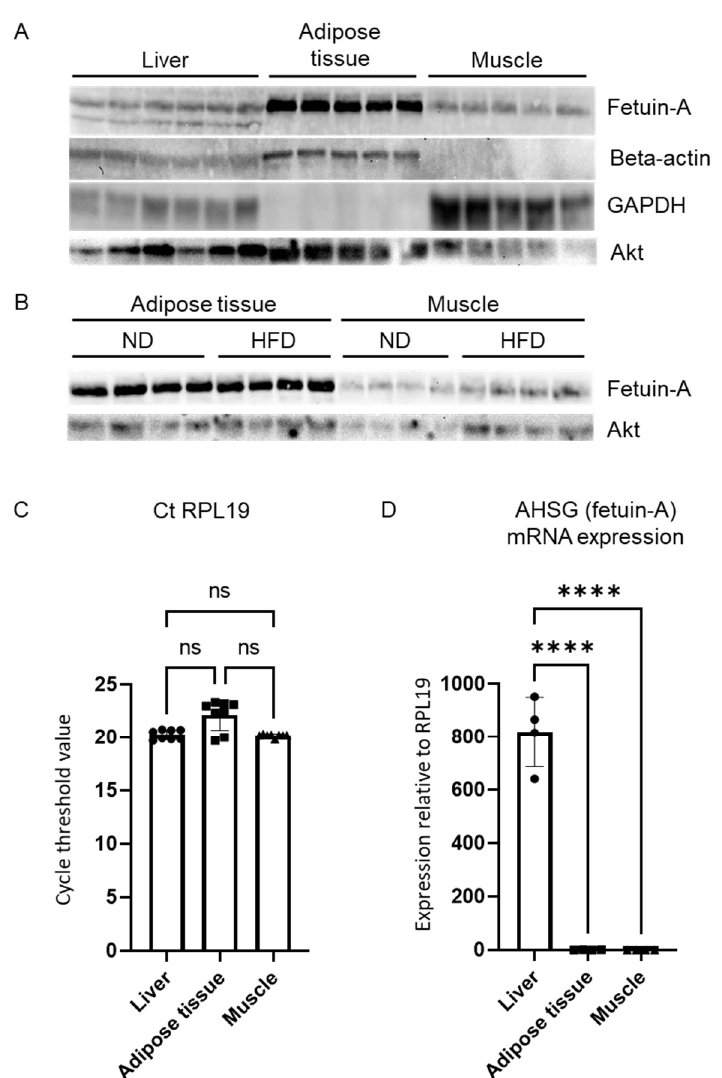
Figure 3. Fetuin-A in insulin sensitive tissues. Comparison of liver, adipose tissue, and muscle protein content of fetuin-A, beta-actin, glyceraldehyde 3-phosphate dehydrogenase (GAPDH), and Akt evaluated by Western blot analysis in mice fed the ND ( A , B ) or the HFD for 3 days ( B ). Mean cycle threshold values of RPL19 in the liver, adipose tissue, and muscle ( C ) evaluated by qPCR analysis. Comparison of liver, adipose tissue, and muscle AHSG mRNA expression with RPL19 mRNA chosen as an invariant standard ( D ). Data are expressed as means ± SD. n = 3–6 per group. ns: nonsignificant, **** p < 0.0001.